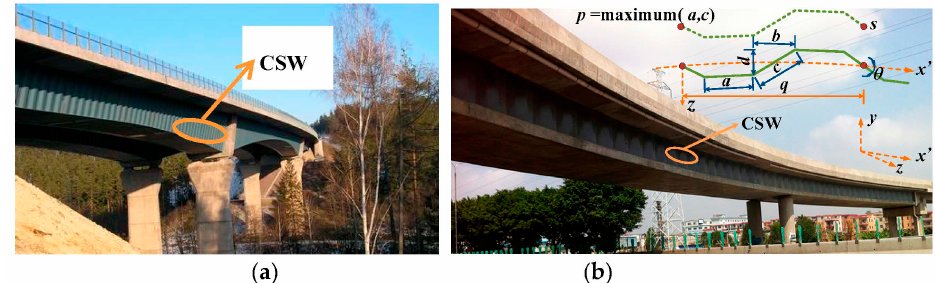
Figure 1. Curved composite girder bridges with corrugated steel webs (CSWs): ( a ) Altwipfergrund Viaduct; ( b ) Yuwotou Bridge. CSW: corrugated steel web.